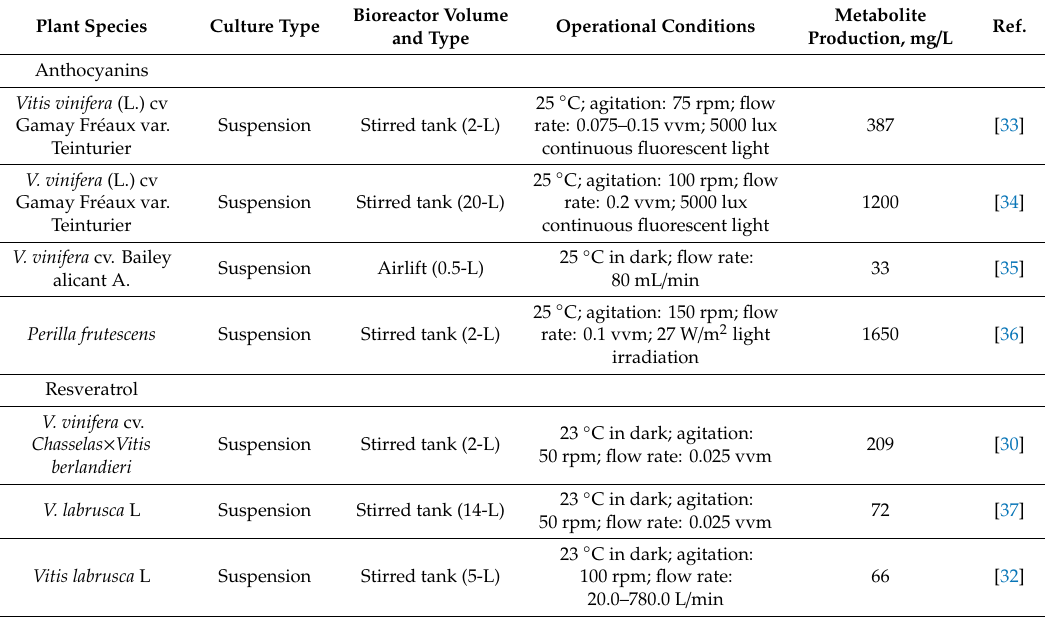
Table 1. Small-scale production of secondary metabolites used as